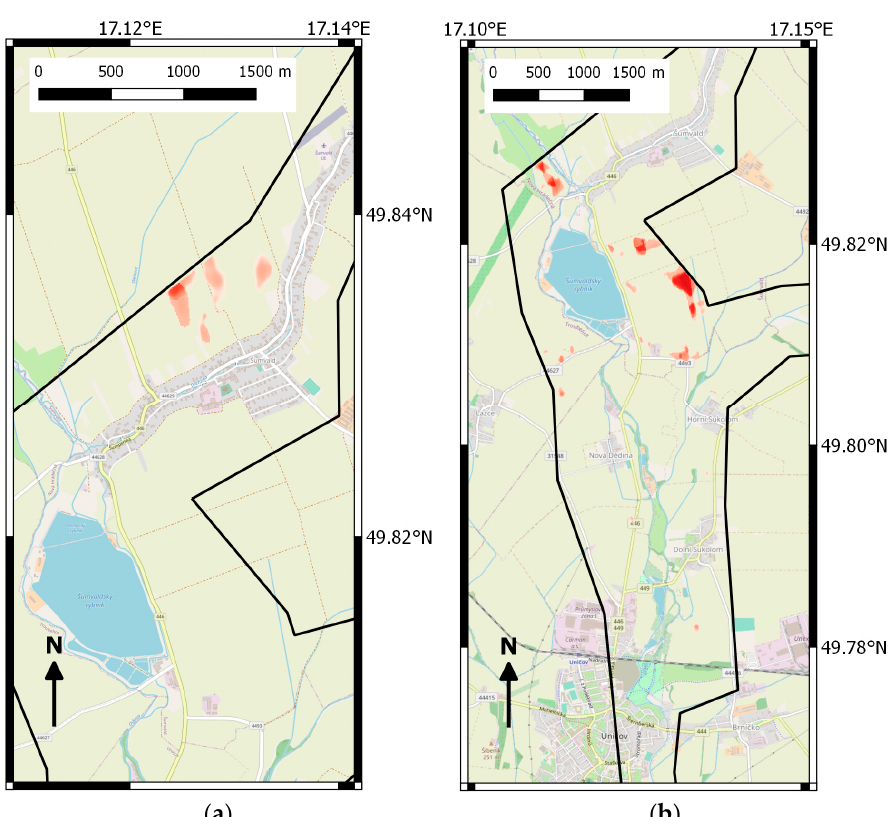
Figure 11. False-positive flood detection in parts of the processed area for the Uni č ov flood event from Sentinel-1 images in track A175 from ( a ) March 25 and ( b ) April 18, 2020. Flooded areas are shown in red using the same colour scale as in Figure 9. The Borderline of the AOI is shown in black.